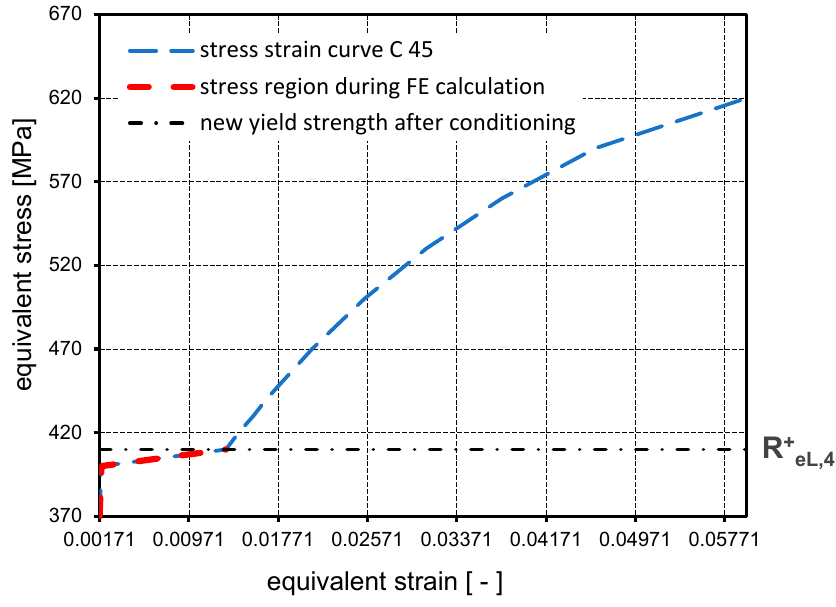
Figure 9. Stress–strain curve of the tensile test from IKAT. In the subsequent purely elastic step-by-step relief up to p i = 0 MPa (point D + ), this equivalent stress then marks the new amount of the yield strength (represented by the black dash-dot line in Figures 4 and 9 and also by the red ellipse in Figure 3). Each reload